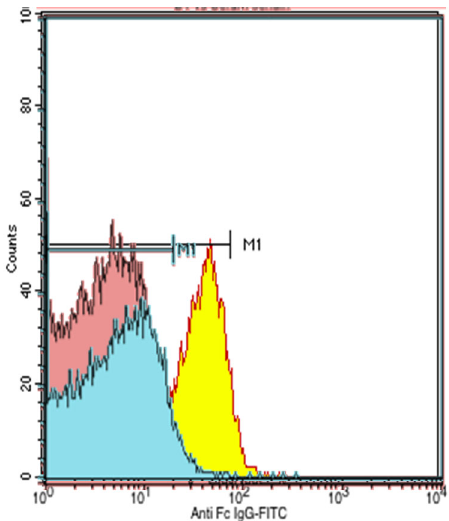
Figure 2. The negative results of the T-lymphocyte flow cytometry